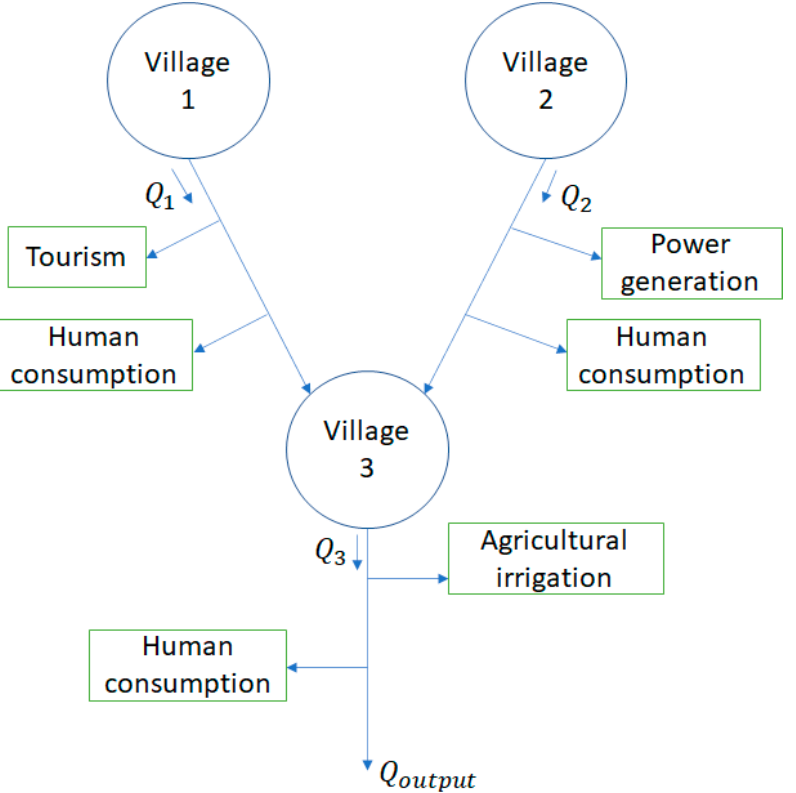
Figure 1. Conceptual model of the study case when implementing the modeling based on NetLogo agents (adapted from [24]).